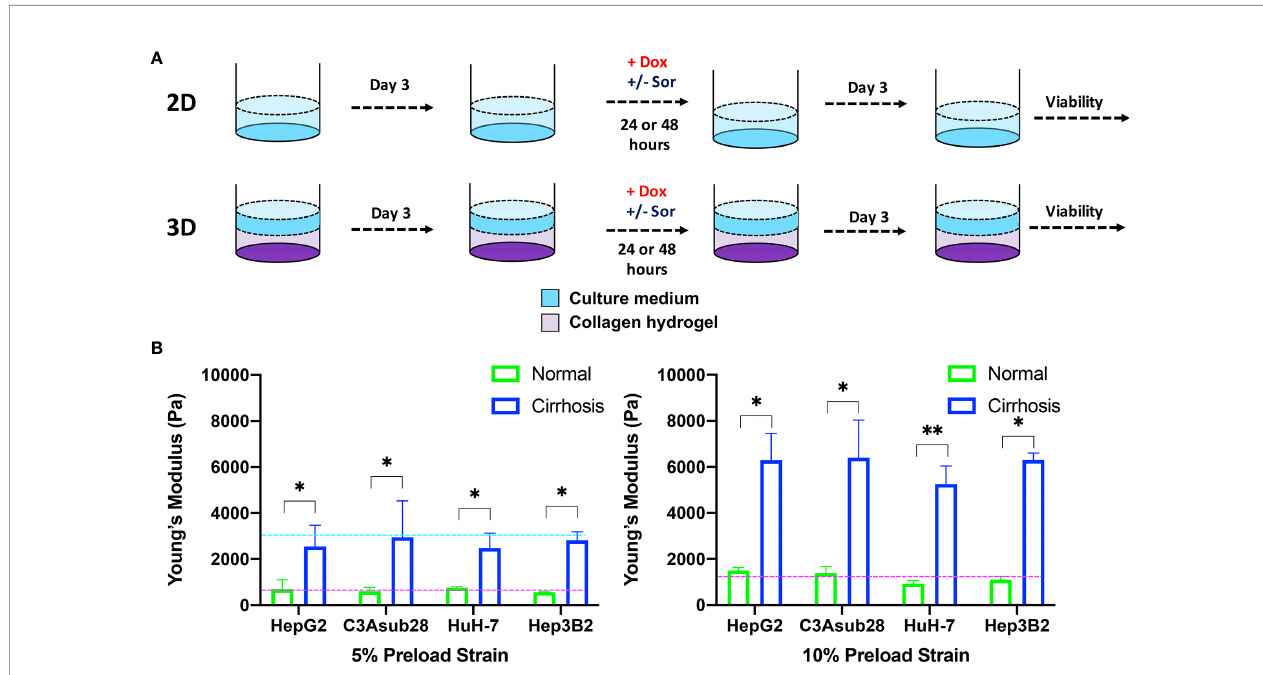
FIGURE 2 | HCC cells cultured in a monolayer or in collagen hydrogels of varying stiffness. (A) Experimental procedure outline. Cells were allowed to adhere and reach their native morphology before the treatment for 24 or 48 hours. (B) Compression modulus of the HCC hydrogels with 4 and 7 mg/ml collagen concentrations, which replicate normal and cirrhotic tissues, respectively. The compression modulus did not vary when different HCC cells were cultured in collagen hydrogels. Compression modulus values were signi fi cantly different when different collagen concentrations were used to replicate normal and cirrhotic conditions. Dashed lines represent patient compression modulus of healthy (magenta) and cirrhotic (magenta) tissues (43, 44). Selected collagen concentrations replicated native tissues successfully at different preload strains. *p < 0.05, **p <